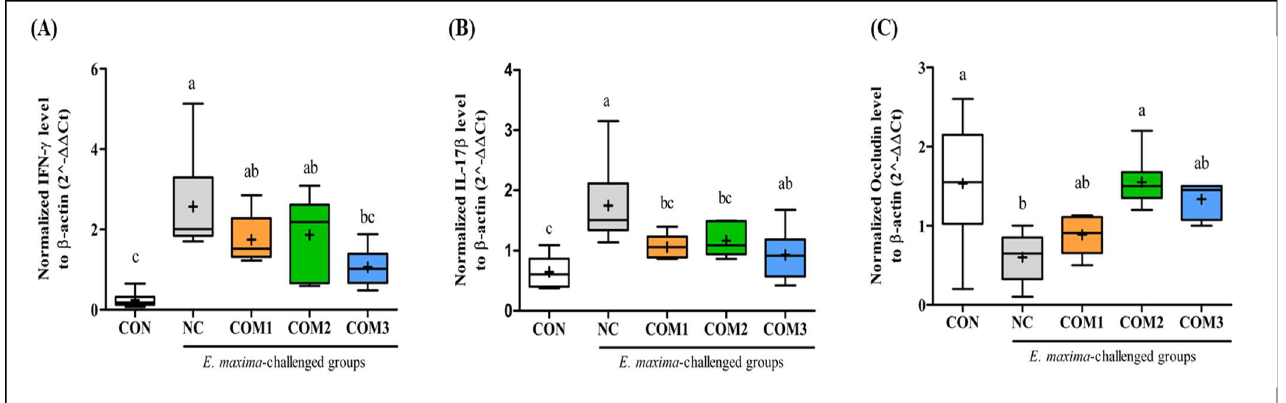
Figure 4. Synergetic effect of recombinant EF-1α and B. subtilis expressing cNK-2 peptide on intestinal expression of IFN-γ ( A ), IL-17β ( B ) and Occludin ( C ) post- E. maxima infection. a–c different letters between group denote significant differences ( p < 0.05) according to the Tukey’s multiple range test ( n = 30). Abbreviations: CON, non-immunized and non-infected control; NC, non-immunized and infected control; COM, component; nd, not detected.